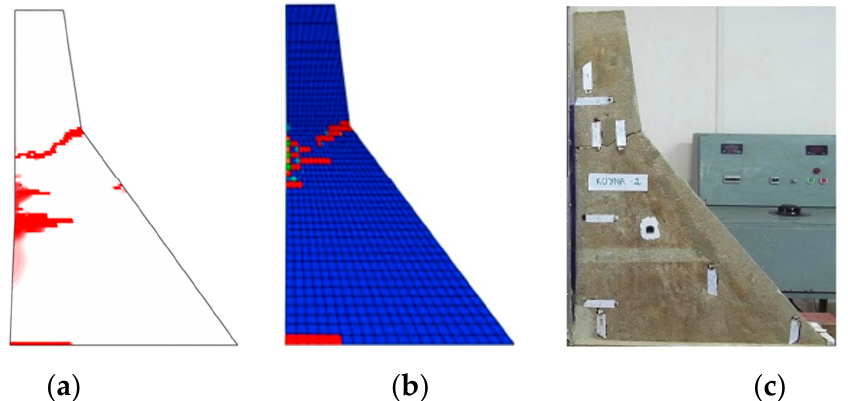
Figure 8. Final failure modes based on: ( a ) coupled acoustic-structural method; ( b ) coupled La- grange-Euler method [43]; ( c ) experimental results from the model test [46].